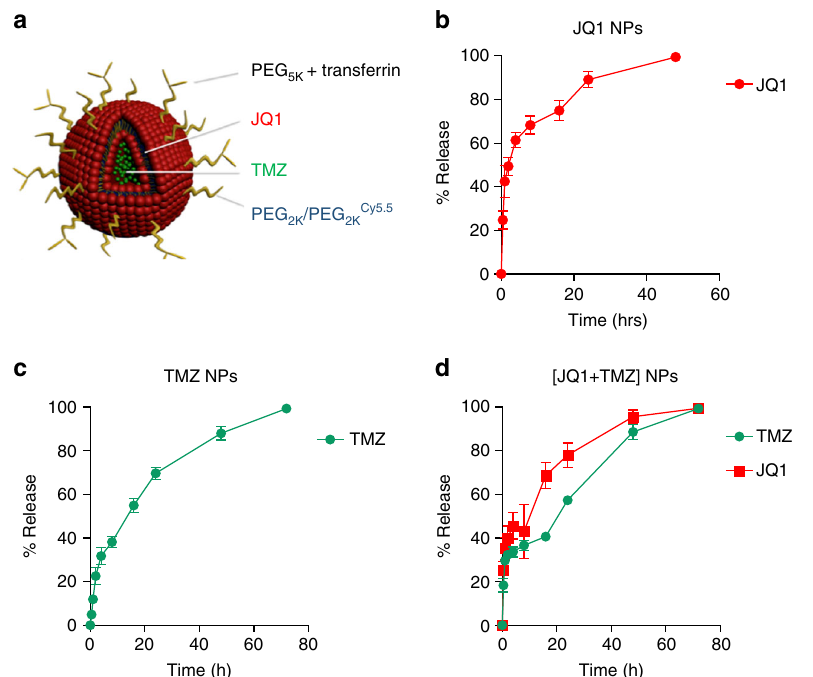
Fig. 4 Characterization of drug release from JQ1 and TMZ liposomes. a Schematic of liposomes loaded with JQ1 and TMZ. Kinetics of drug release from liposomes loaded with b JQ1 alone, c TMZ alone, or d both JQ1 and TMZ. Data presented as mean ± SEM of three separate